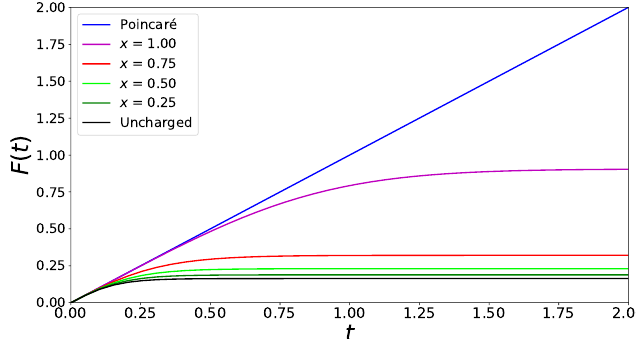
Figure 9 . The reparametrisation F ( t ) (6.25) plotted for various x with fixed energy E 0 = 20 , fixed k = 0 . 1 and K = 4 C . As the charge increases, the profile F ( t ) gets closer to the Poincaré solution F ( t ) = t than the uncharged